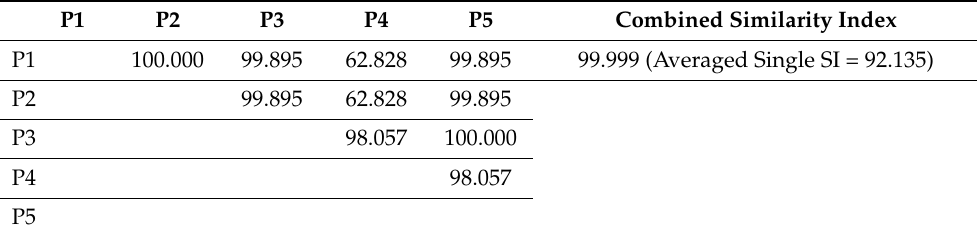
Table 4. Case-A Similarity Index (SI). Case-A calculated SI utilizing Equation